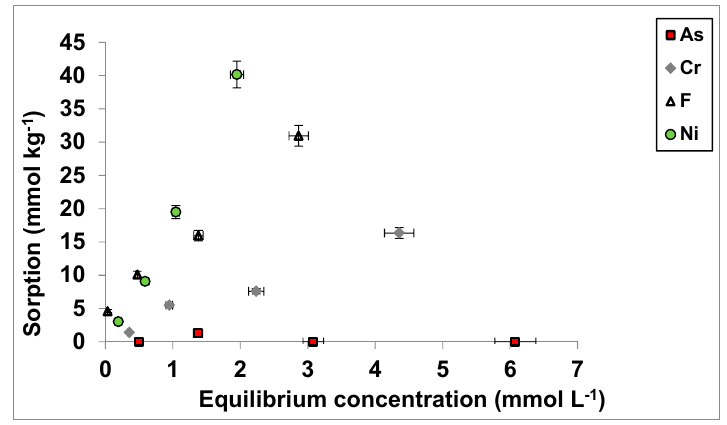
Figure 2. Sorption curves for As, Cr, F, and Ni. Average values (with error bars) for 3 replicates, with coefficients of variation always <5%.